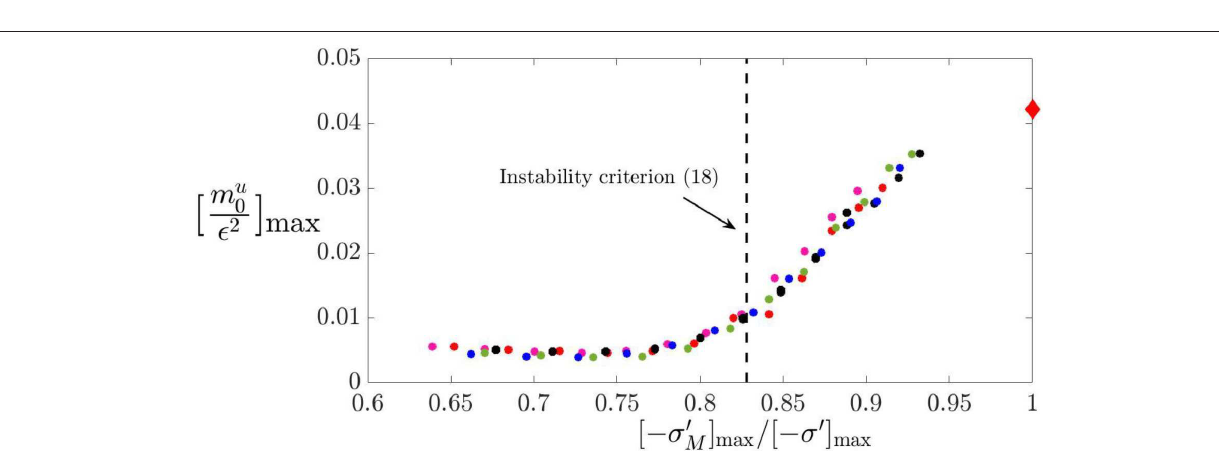
g )] σ ′ M ( is a good indicator of the effect of roughness on instability. The point max ¯ −